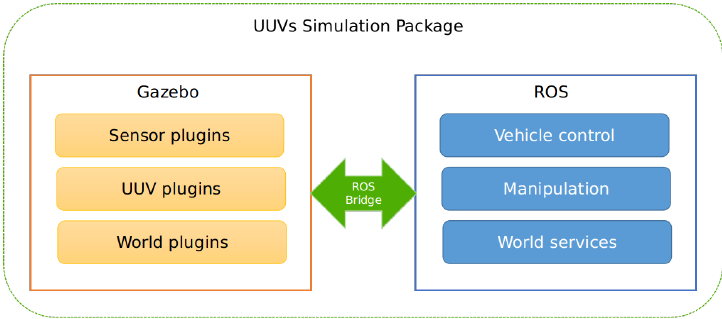
Figure 1. UUV Simulator: Software structure inspired by Manhães et al.